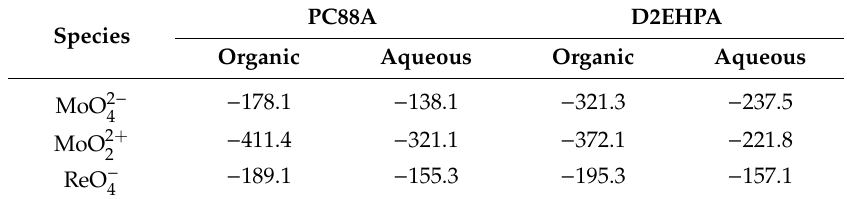
Table 7. Interaction energy (kJ / mol) species with extractants in the organic and aqueous phases. PC88A D2EHPA Species Organic Aqueous Organic Aqueous − 178.1 − 138.1 − 321.3 − 237.5 − MoO 2 4 − 411.4 − 321.1 − 372.1 − 221.8 MoO 2 + 2 − − 189.1 − 155.3 − 195.3 − ReO 4